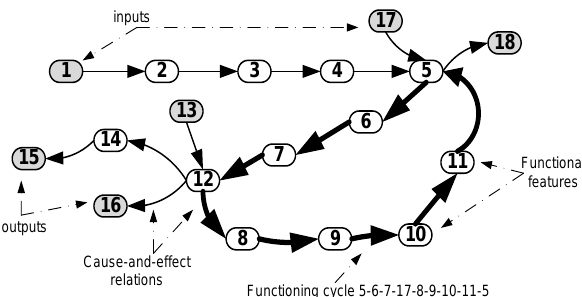
Fig. 2. The functional properties of the topological functioning